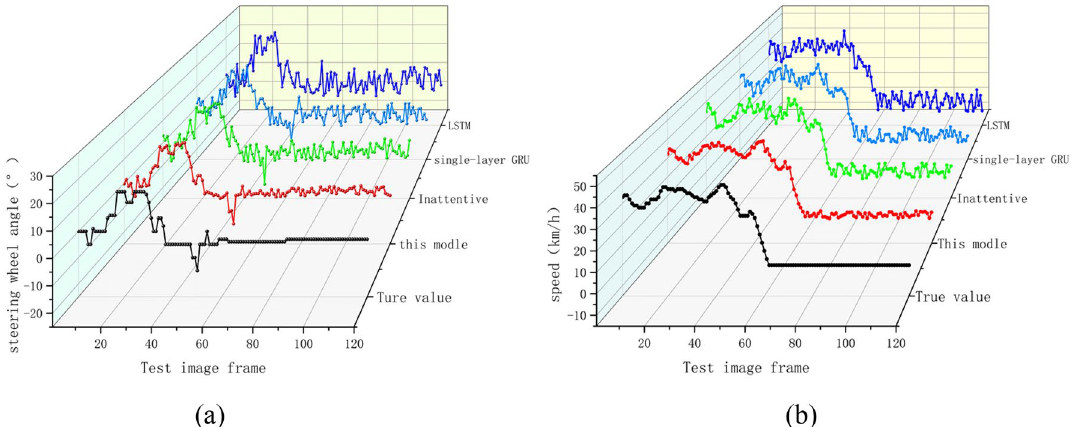
Figure 7. Comparison of vehicle driving data prediction results ( a ) steering wheel angle prediction; ( b ) predicted vehicle speed.